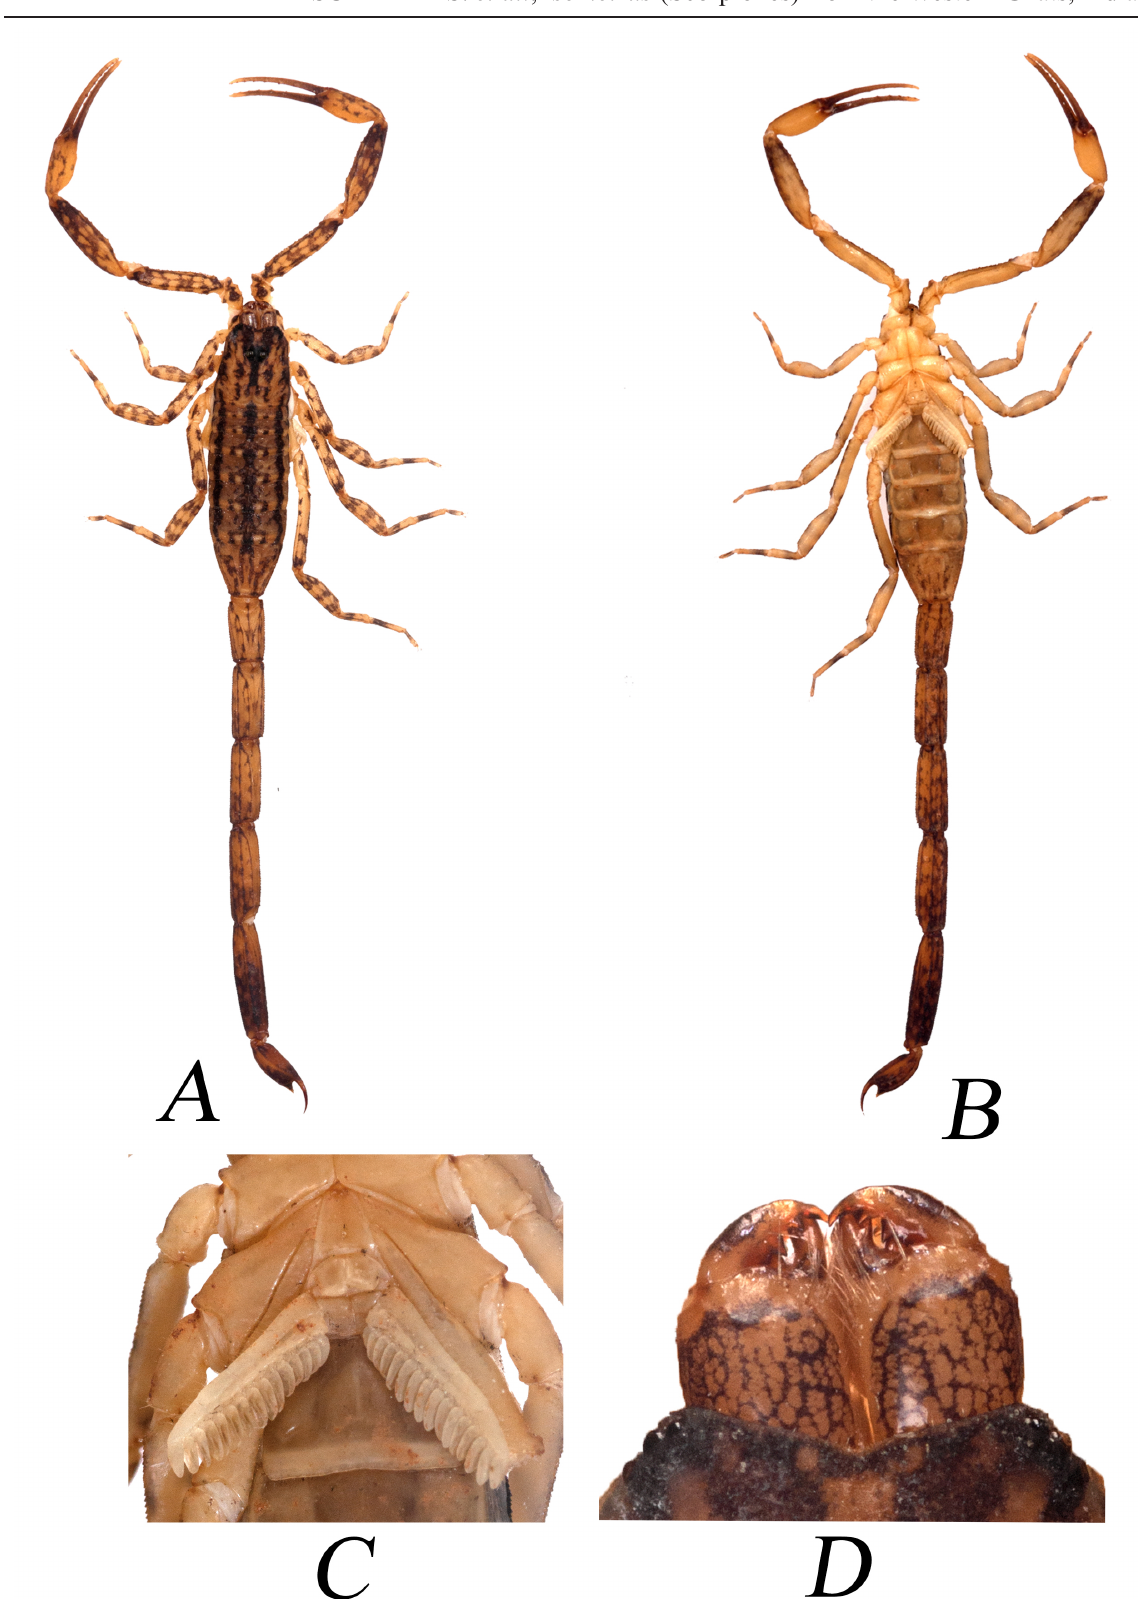
Fig. 4. Isometrus sankeriensis Tikader & Bastawade, 1983, neotype, adult ♂ (BNHS SC 194). A . Dorsal view. B . Ventral view. C . Sternopectinal area, dorsal view. D . Chelicerae, dorsal